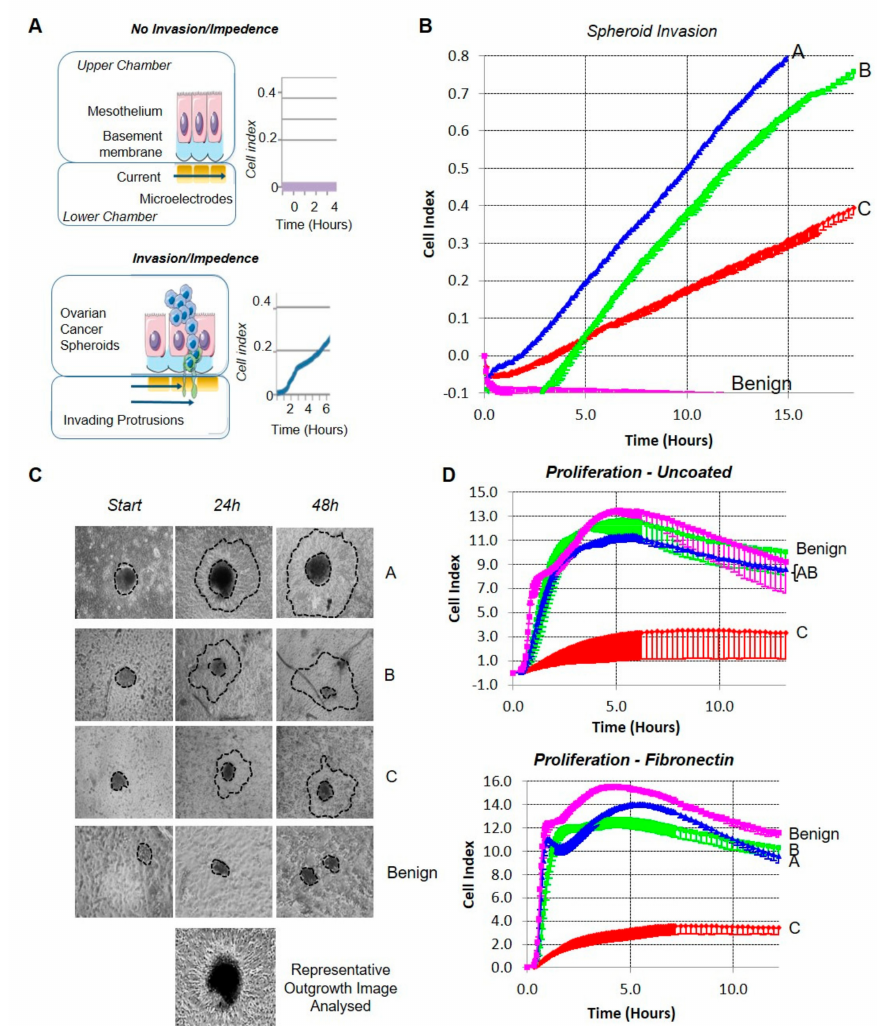
Figure 1. ( A ) Peritoneal microenvironment model. A mesothelial monolayer is grown on the basement membrane in the upper chamber of an xCELLigence CIM plate; the lower chamber contains media and microelectrodes. Disruption of the mesothelial cell layer (clearance) and the invasion of ovarian cancer cells alters the current flow and creates impedance, resulting in an increased cell index as a measure of invasion. ( B ) Real-time cell analysis (RTCA) invasion assay. Three patient-derived high-grade serous (HGS) ovarian cancer / mesothelial co-cultures (A—blue, B—green, C—red), and one benign fibroma / mesothelial (pink) co-culture were monitored in real time over an 18-h period, mean 15-min impedance readings with lower standard deviation are shown; n = 2 wells / sample of a representative experiment are shown. ( C ) Mesothelial clearance. Parallel assays demonstrating mesothelial clearance by the three patient-derived ovarian cancer spheroids (A–C) but not benign fibroma spheroids over 48 h with a representative image are shown. ( D ) RTCA adhesion and proliferation. The adhesion and proliferation of patient-derived ovarian cancer cells (A–C) and the benign control on uncoated and fibronectin-coated wells was measured by RTCA assay. Samples were monitored over a 13-h period with mean 5-min impedance and lower standard deviation shown; n = 2 wells / sample of one representative